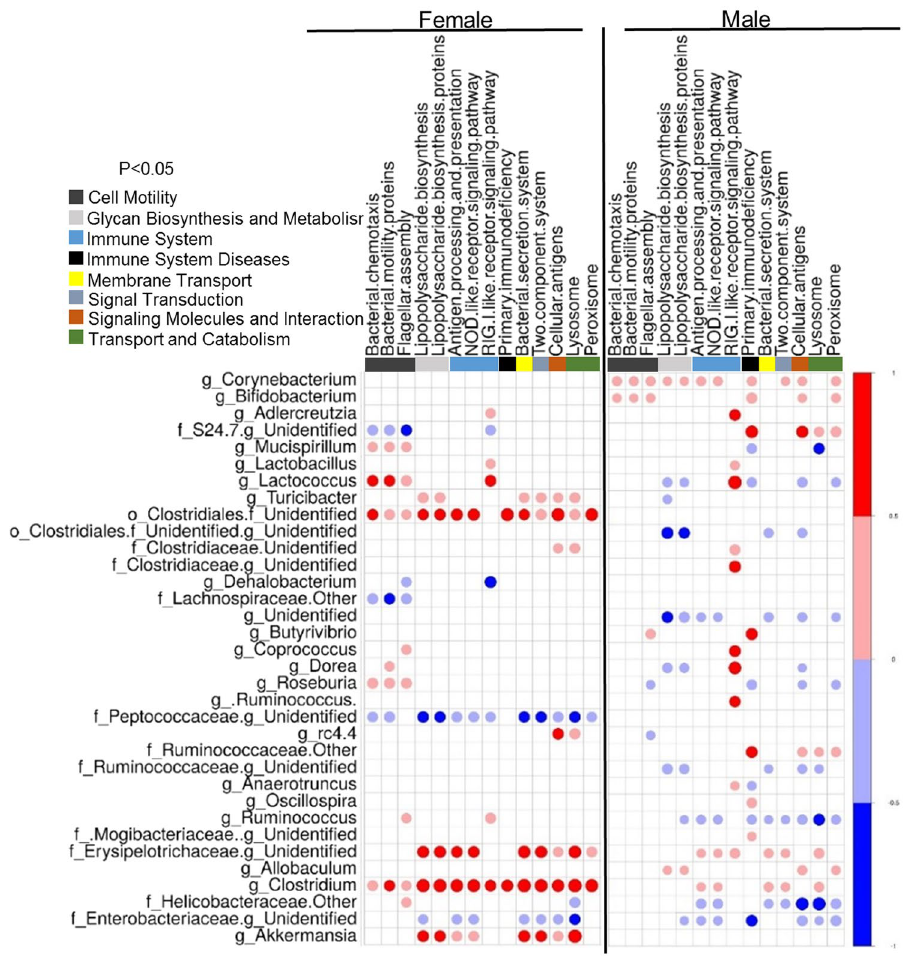
Figure 6. Maternal HFD and offspring sex significantly alter immunological pathways. Correlations between a PICRUSt-generated functional profiles and genus level bacterial abundance were calculated and plotted between HFD-fed male (M-HH) and female (F-HH) offspring from HFD-fed dams. Immunological pathways designations are indicated at the top of the graph. Left panel of the graph represents HH-female offspring while HH-male offspring are presented on the right panel. The shading intensity of the bubble, along with size, is indicative of the Kendall rank correlation coefficient between matrices. Red designates a positive association while blue designates a negative association. Only significant (p ≤ 0.05 by Kendall’s test; n = 5–7) correlations are visible in the